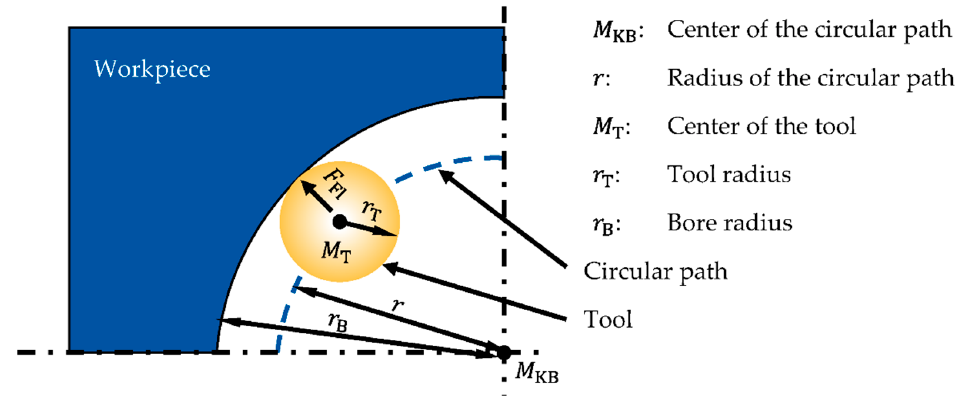
Figure 1. Schematic structure of a centrifugal force-based tool.